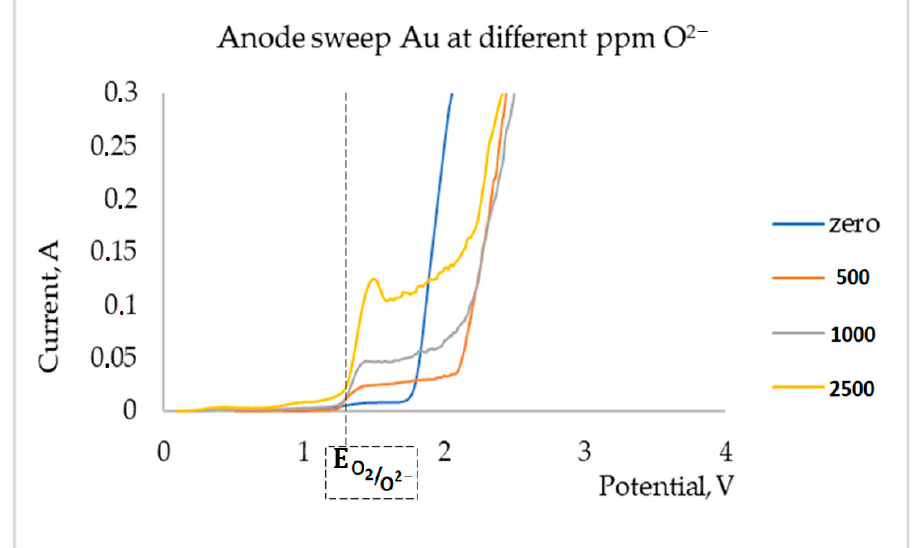
Figure 1. Voltage dependences in a FLiNaK melt with a gold anode. According to the obtained voltage dependences, the current increased proportionally to the lithium oxide concentration in the melt. We confirmed the given concentrations of lithium oxide by anodic polarization. Steel 12Cr18Ni10Ti (Fe-based alloy, 18Cr-10Ni, 0.8 Ti, 0.12 C wt.%) was used as the material for test samples. Before the test, the samples were grounded and polished with abrasive paper of various grain sizes, degreased and dried. After that, their dimensional characteristics were measured with a digital caliper and the mass by the analytical scales AND GR-202. 3. Results and Discussion Figure 2 shows the appearance of the samples under study, as well as the solidified melt (Figure 3). ( а ) ( g ) Figure 2. Appearance of the studied samples. ( a ) The original sample; samples were aged in a FLiNaK melt at a concentration of О 2 − : ( b ) 500 ppm, ( c ) 1000 ppm, ( d ) 1500 ppm, ( e ) 2500 ppm, ( f ) 4500 ppm, ( g ) 8000 ppm.